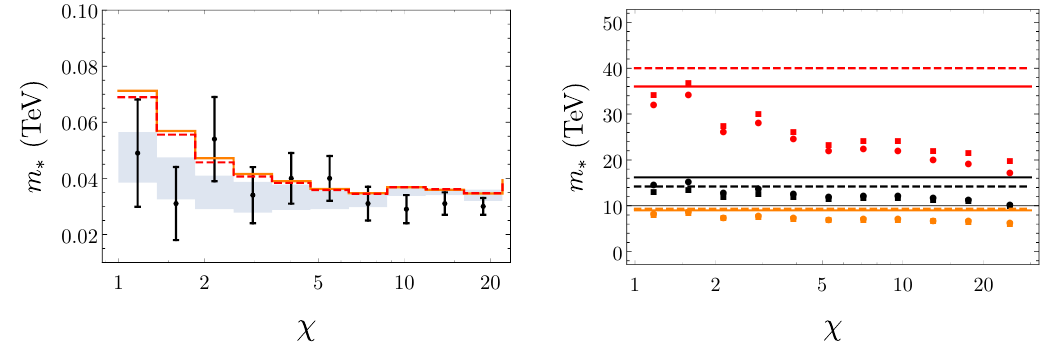
Figure 3 . Left: dijet angular distributions in the highest-energy bin M jj > 5 : 4 TeV, for the experimental data with its systematic plus statistical uncertainties (black points), the SM prediction with its theoretical error (blue band), and the BSM predictions for the dimension-8 operator O dd (solid orange) or the dimension-6 operator O (1) [3] (dashed red). The corresponding (positive) dd coe(cid:14)cients have been chosen to saturate the bounds eqs. (5.4) and (5.5). Right: bounds on the scale m (cid:3) for a composite d R with a dimension-8 operator j c dd j = (4 (cid:25) ) 2 = 2 m 4 (orange) or a dimension- (cid:3) 6 operator j c (1) j = (4 (cid:25)=m (cid:3) ) 2 (red) and for all quarks composite with dimension-8 operators j c ij j = dd (4 (cid:25) ) 2 = 2 m 4 (black), for di(cid:11)erent (cid:31) bins (dots) and for all bins combined (lines). The round dots (cid:3) and solid lines correspond to c > 0 while square dots and dashed lines to c <